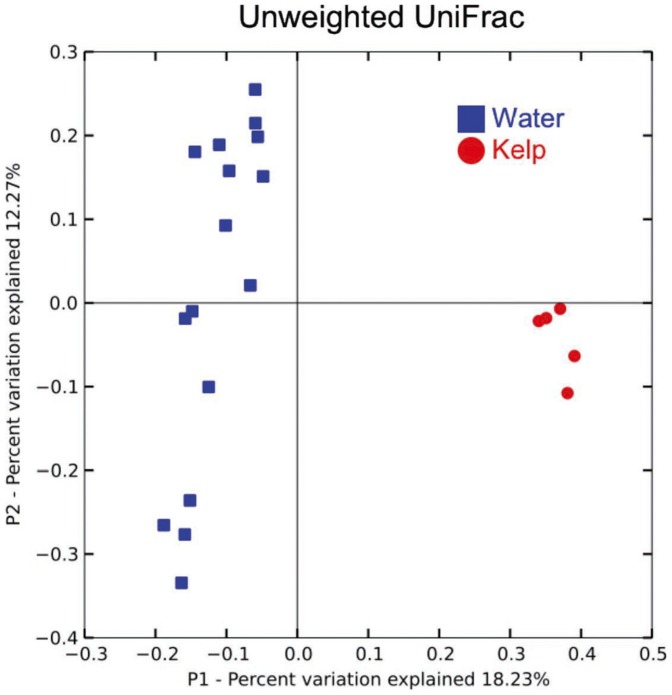
Unweighted UniFrac principal coordinates analysis (PCoA) plots computed at exactly 510 sequences/sample illustrate the relationship between sample type (blue  =  water, red  =  kelp) community similarities.Percentages of variance explained by each principal coordinate (P1 and P2) are shown on the x- and y-axes.